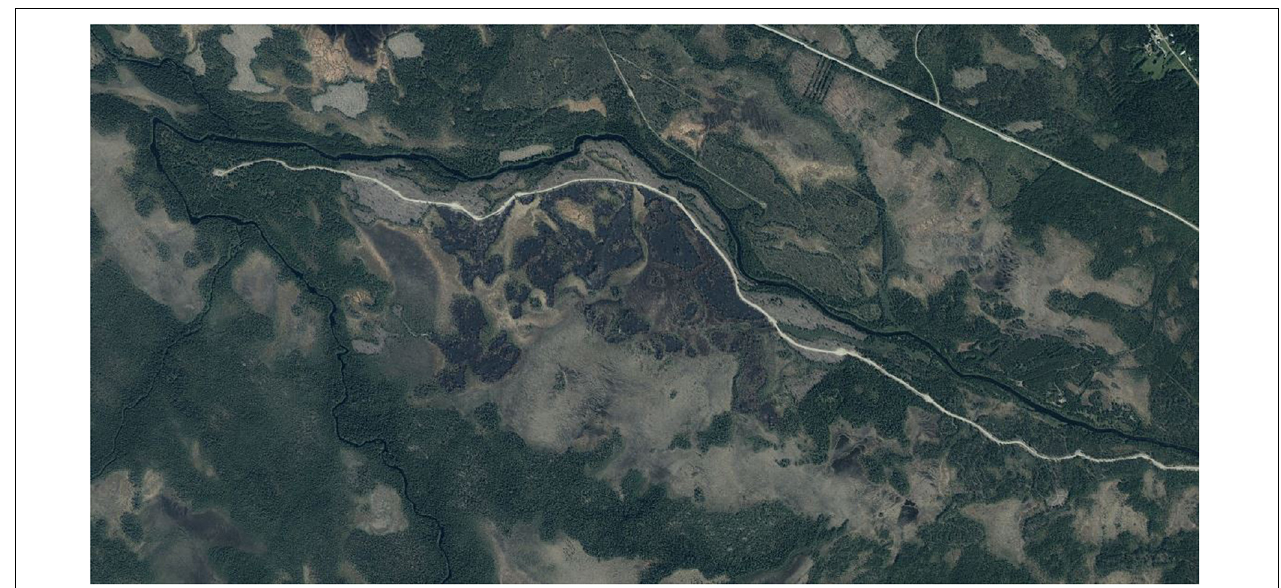
FIGURE 5 | Burnt forest patches after the 2018 forest fires on the right bank of Örån, west of Björkberg, Lycksele municipality, Sweden.